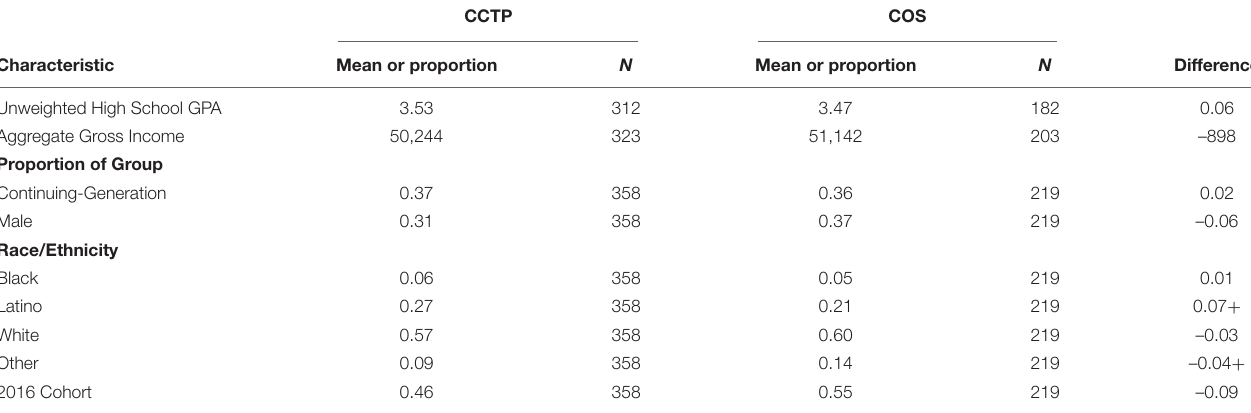
TABLE 1 | Student characteristics by program group.